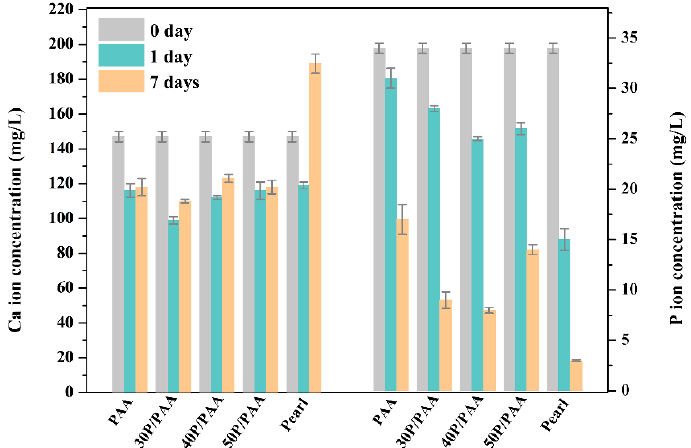
Figure 6. Variation of the Ca ion (left) and P ion (right) concentrations of SBF after the samples soaked for 0, 1, and 7 days.